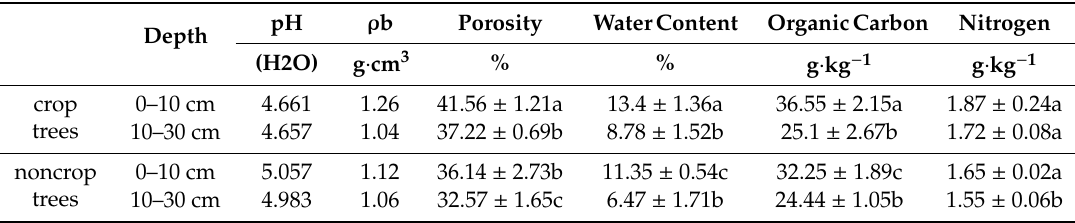
Table 5. Soil physical and chemical properties.